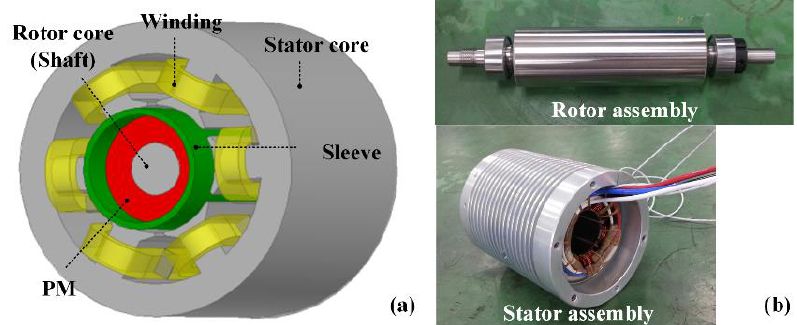
Figure 1. Structure of the HPMSM: ( a ) analysis model and ( b ) prototype. Table 1. Specifications of the HPMSM.